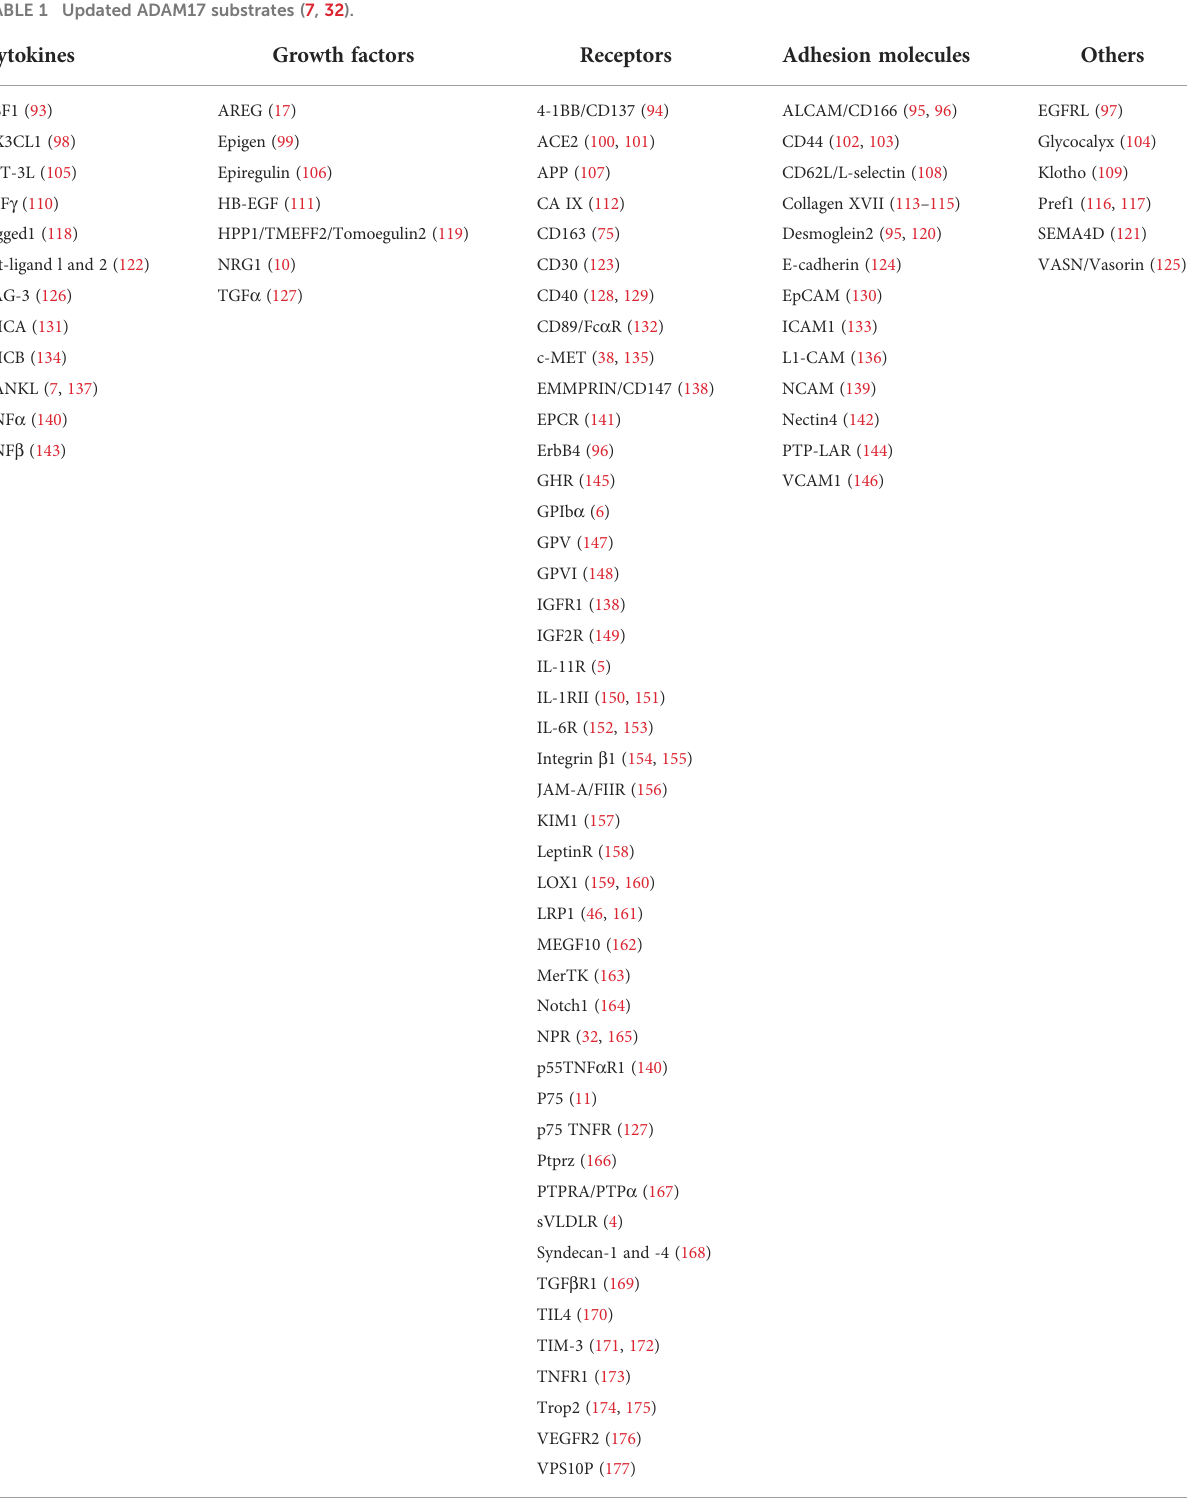
TABLE 1 Updated ADAM17 substrates (7, 32). Cytokines Growth factors Receptors Adhesion molecules